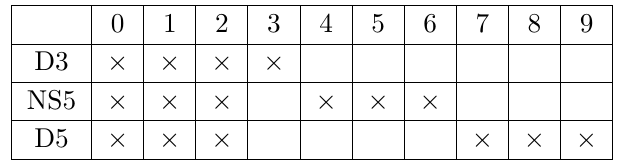
Table 2 . Brane construction of the 3 d quiver